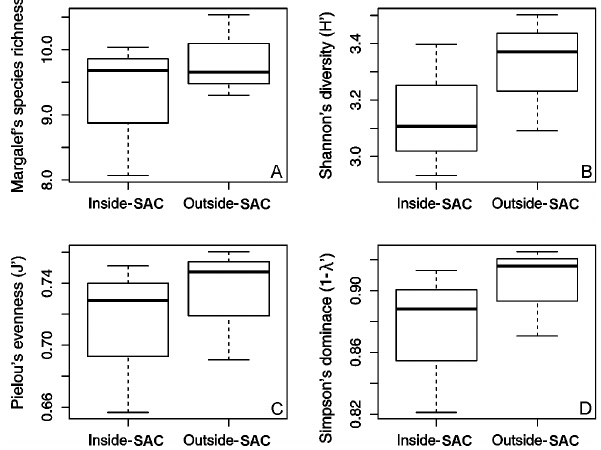
Fig. 3. Box-and-whisker plots of biodiversity indices (A–D) inside and outside the